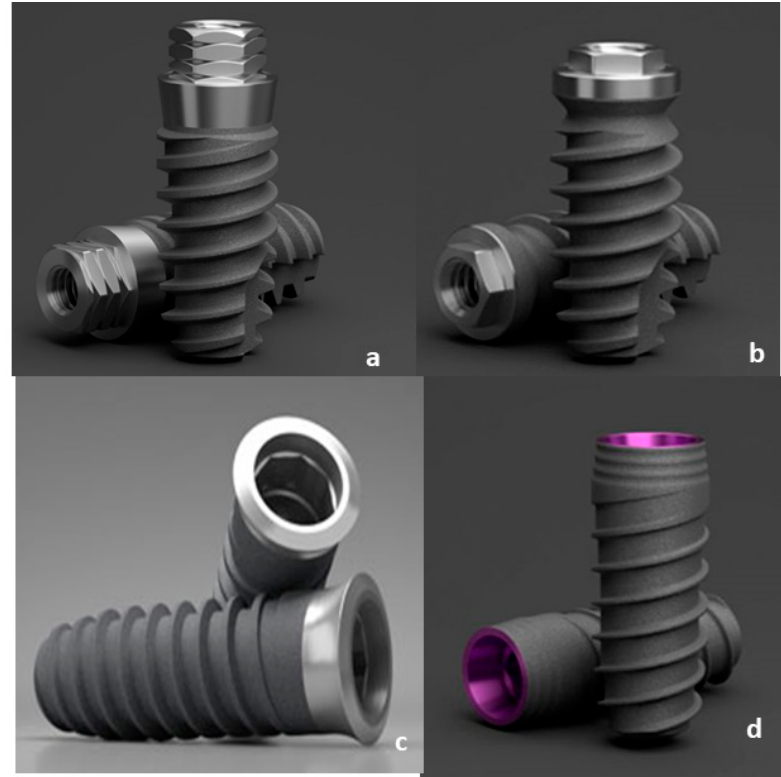
Figure 1. Implants studied: ( a ) SK2 dental implant (S); ( b ) KL dental implant (K); ( c ) ESSENTIAL ® dental implant (E); ( d ) VEGA ® dental implant (V).